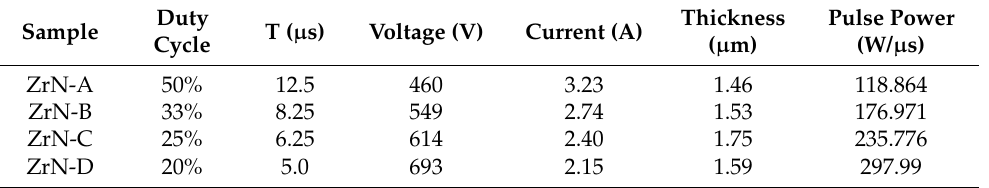
Table 1. Deposition parameters and thickness of deposited of ZrN